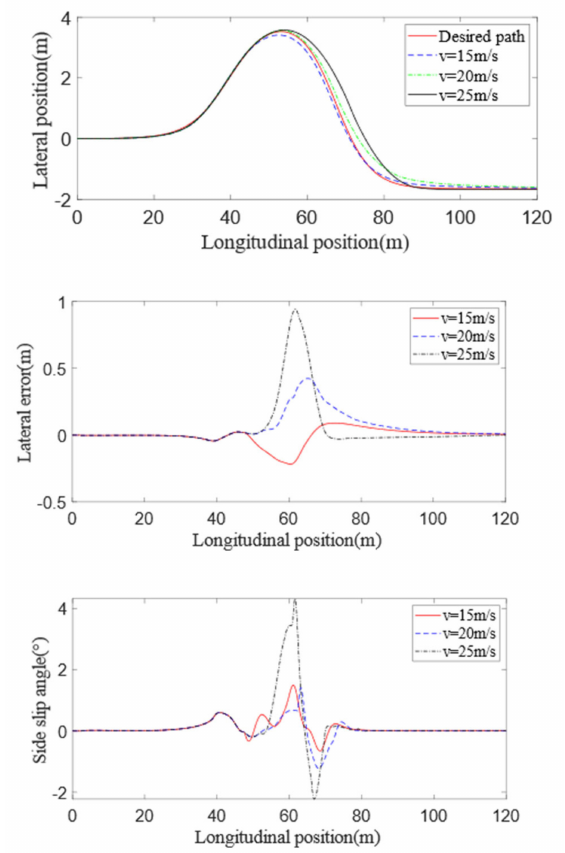
Figure 28. Performance comparison at different